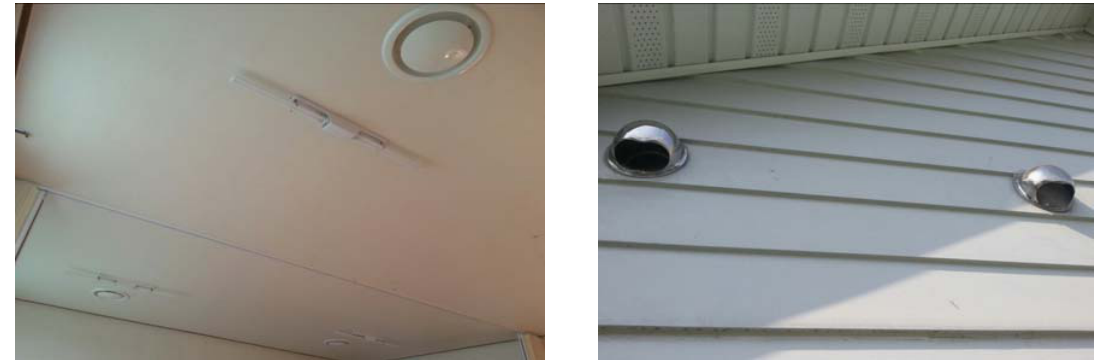
Figure 7. Intake and diffusion inside and outside of the experimental house.